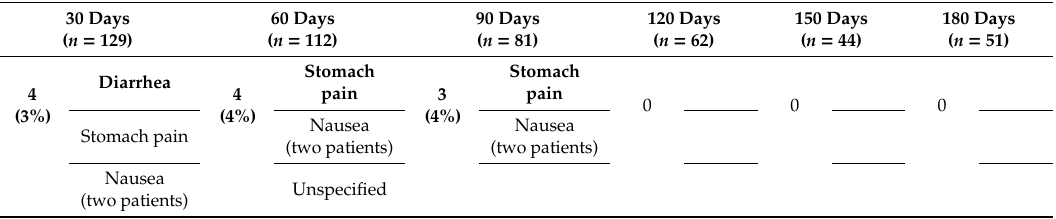
Table 4. Adverse e ff